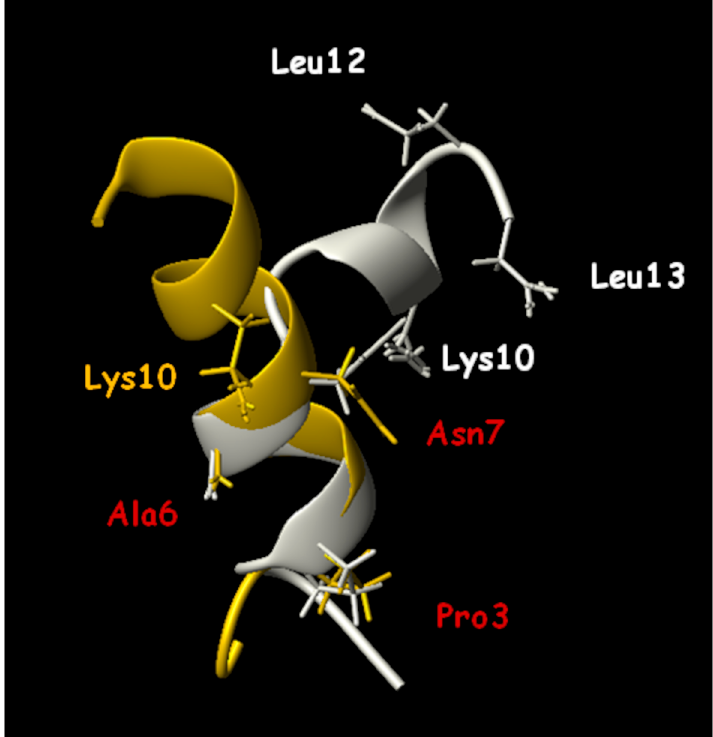
Figure 1. Superposition of the two structures of peptide TB_KKG6A, analogue of temporin B, obtained in the two different systems. In light grey, the structure in LPS; in gold, the TB_KKG6A structure obtained in the cellular context. The interacting residues that assume very similar orientations in the two environments are indicated in red. Reprinted with permission from Malgieri et al. ACS Chem. Biol. 2015, 10, 4, 965–969. Copyright 2015 American Chemical Society.